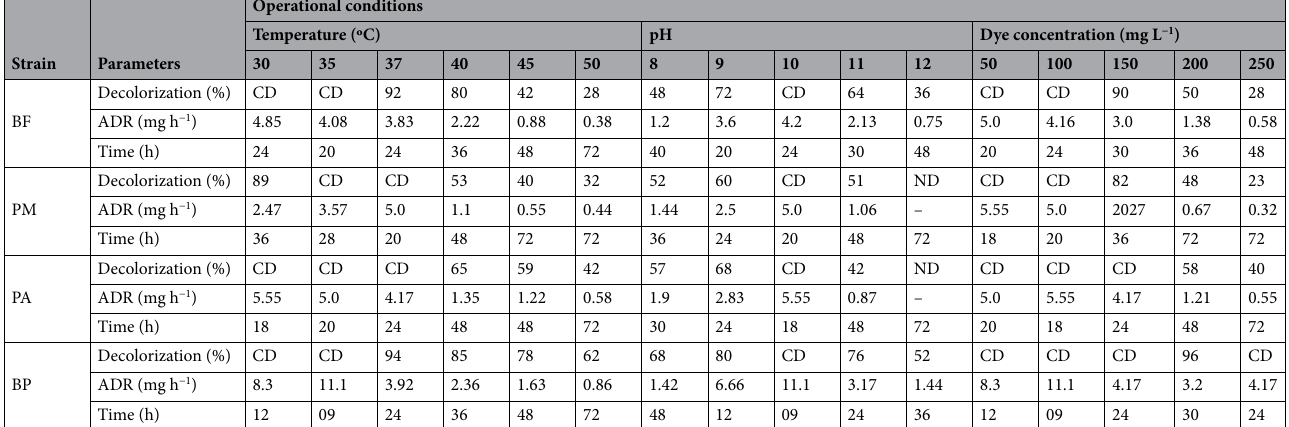
Table 2. Decolorization performance and an incubation time of Indanthrene Blue RS using individual strains and developed consortium-BP at different temperatures, pH, and dye concentrations. ADR: Average decolorization rate (mg h −1 ), CD: complete decolorization, ND: no decolorization, BF: Bacillus flexus TS8, PM: Proteus mirabilis PMS, PA: Pseudomonas aeruginosa NCH, BP: developed